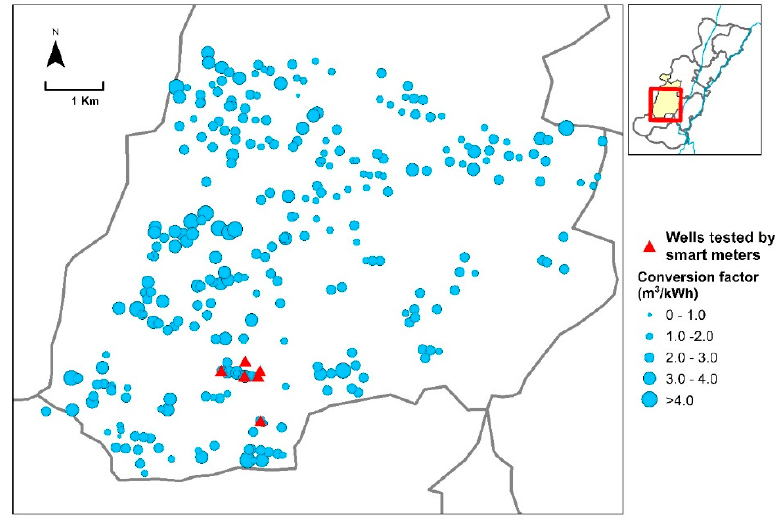
Figure 3. Conversion factors at individual wells tested in the pilot area in Guantao County.